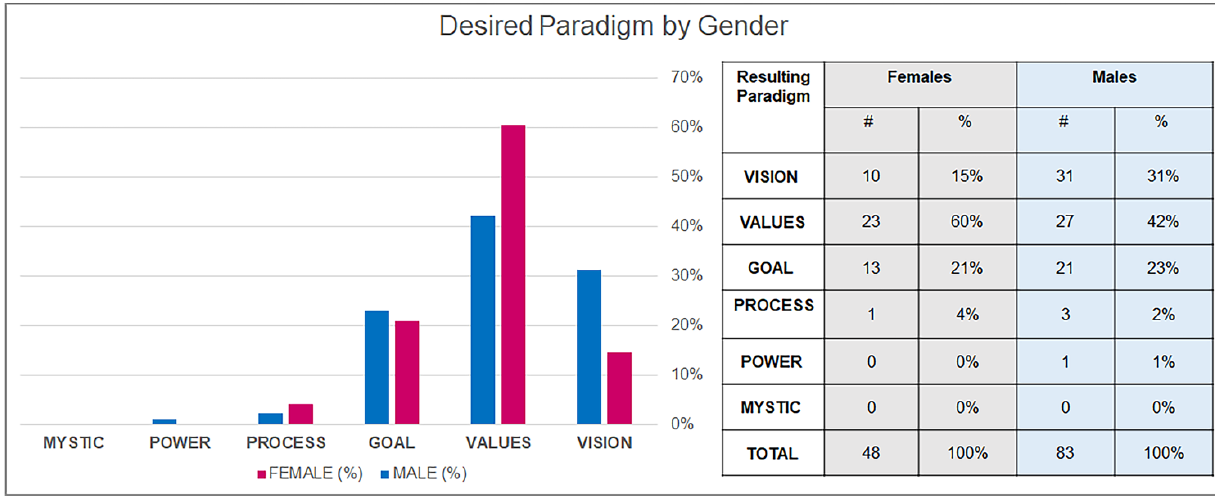
Fig. 4. Left: Summary of participants with selected paradigm. Right: Absolute and relative number of participants with the respective selected